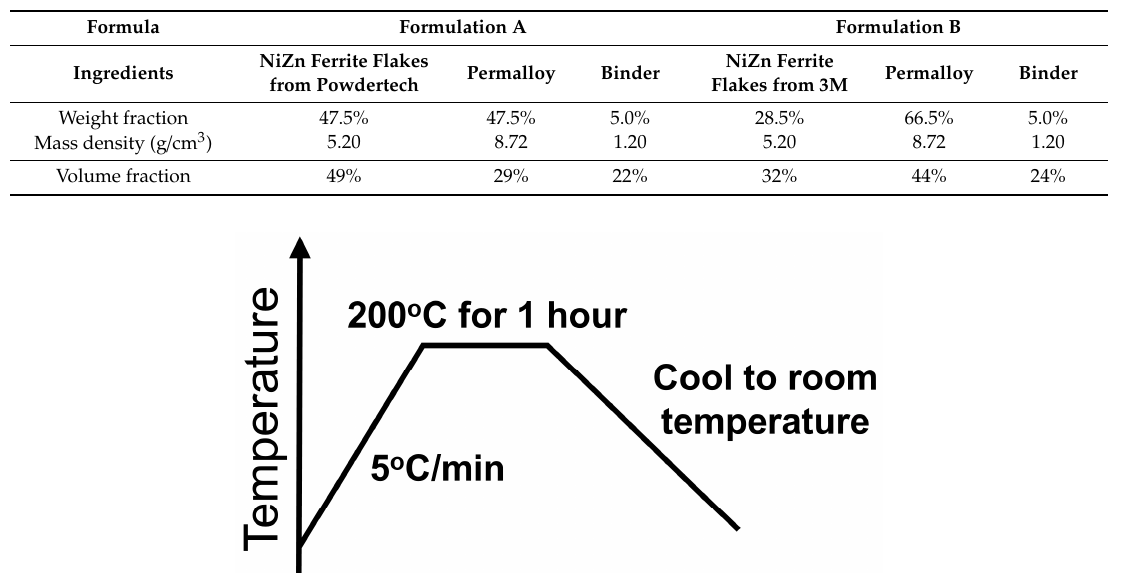
Figure 1. The heating profile used to turn the paste formulations into solid SM 2 C cores.